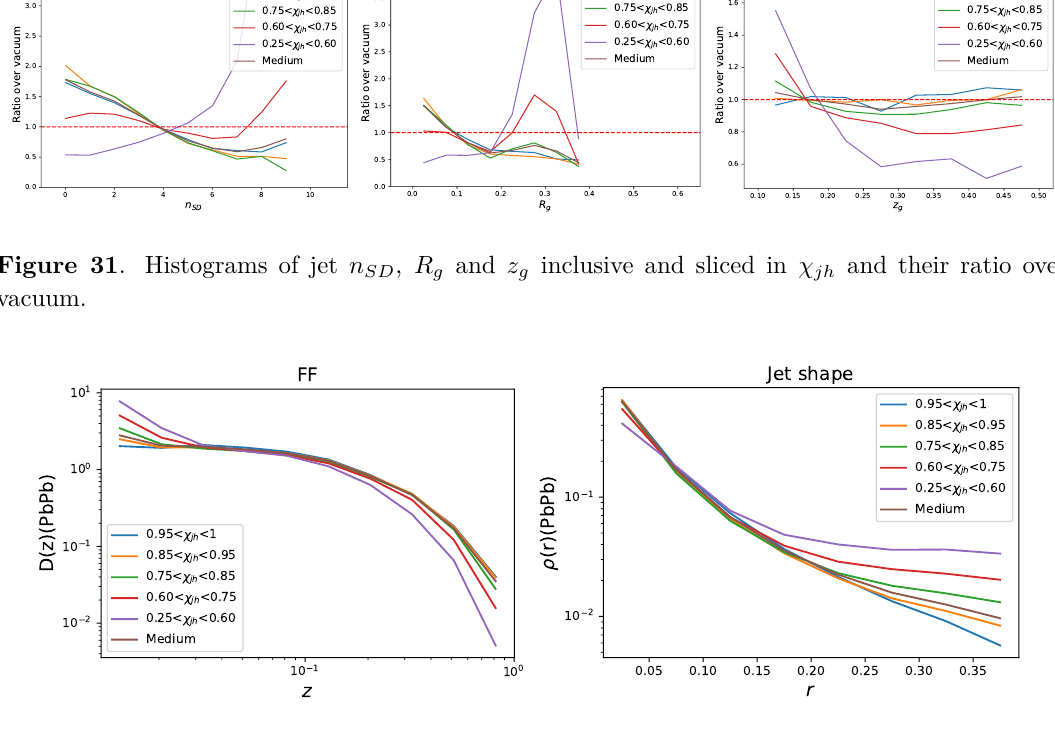
Figure 32 . JFF and jet shape inclusive and sliced in χ jh